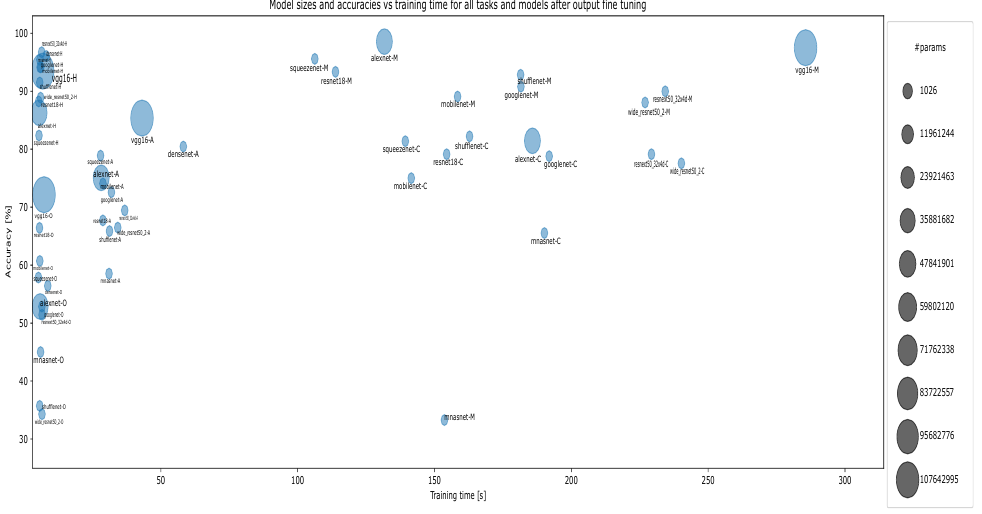
Figure A16. Model sizes and accuracy vs. training time for all tasks and models after fine-tuning classifier layer only, where A refers to Augmented smartphones, C to CIFAR10, H to Hymenoptera, M to MNIST, and O to the Original smartphone